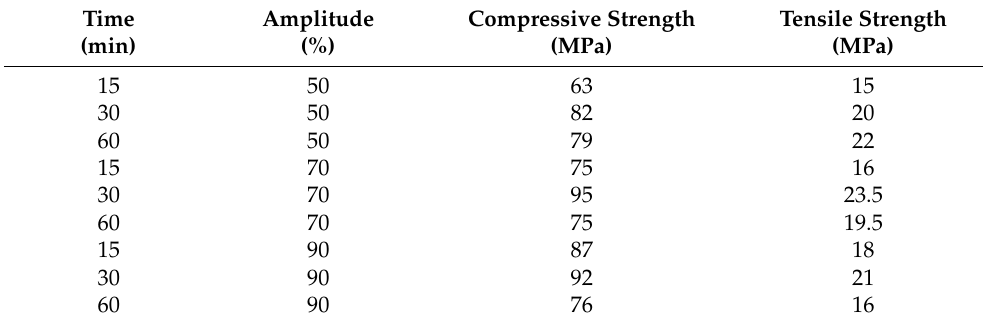
Table 2. Experimental values of compressive and tensile strengths with varying amplitudes and